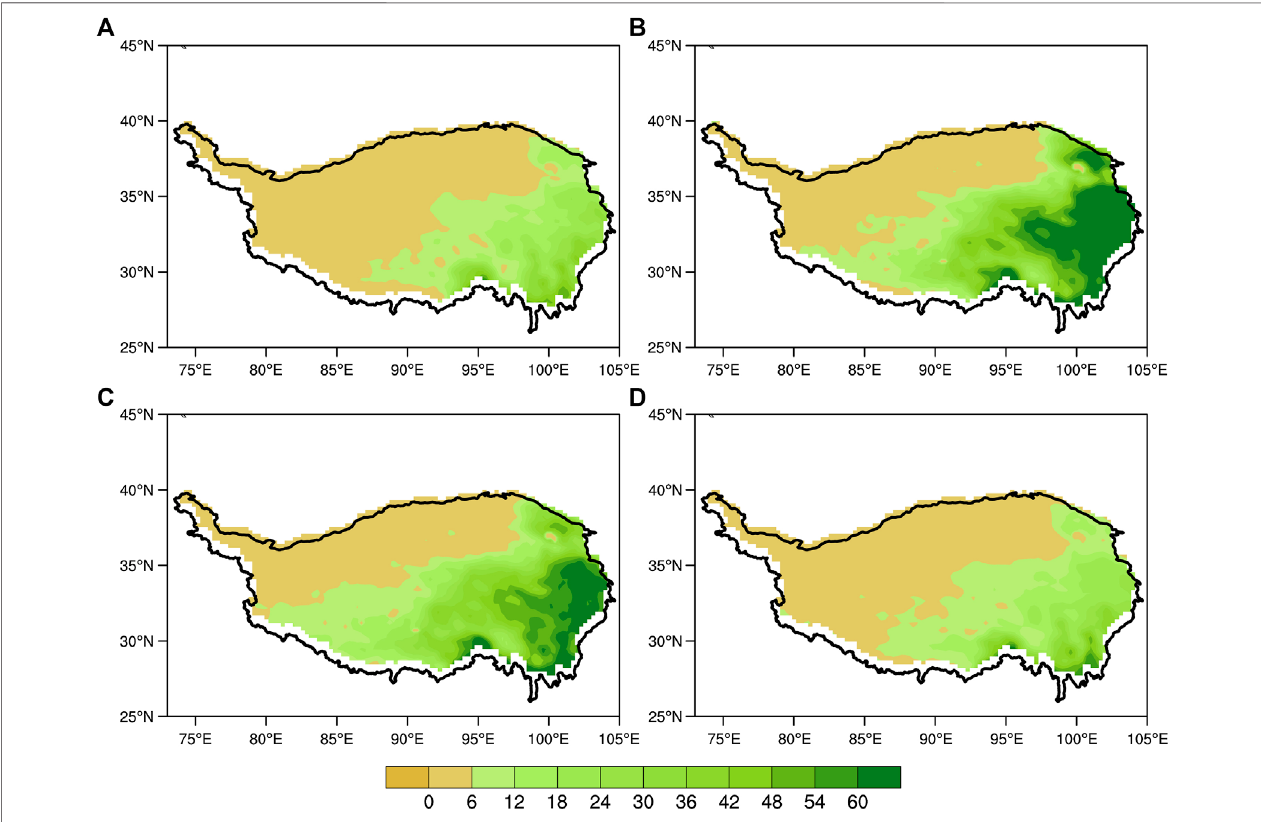
FIGURE 4 | The spatial distribution characteristics of Green Vegetation Fraction in different seasons of High-Resolution Assimilation Dataset of the Water-Energy Cycle in China in Qinghai-Tibet Plateau (Unit: %). (A) MAM, (B) JJA, (C) SON, (D) DJF.